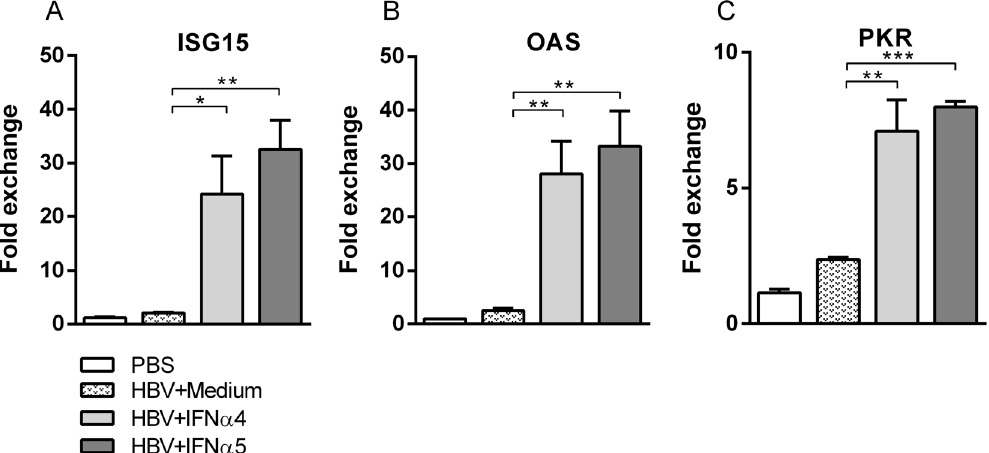
Figure 2. Induction of ISG15, OAS and PKR expression post treatment with recombinant IFN α 4 or IFN α 5. Mice received HI with 10 µ g of pAAV-HBV1.2 plasmids. Mice were treated i.p. with 8000 units of recombinant IFN α 4 or α 5 protein starting from days − 1 to 3 post HI. Control mice received either HI with PBS (PBS) or were treated i.p. with media (HBV + Medium). Total RNA was extracted from liver tissue at day 4 post HI and the mRNA expression levels of ( A ) ISG15, ( B ) OAS and ( C ) PKR were determined by qRT-PCR. The β -actin mRNA expression was quantified for normalization. Each sample was run in duplicate and at least four mice per group were analyzed. Differences between the groups were analyzed by using the One-way ANOVA. Statistically significant differences between the IFN-treated groups and the untreated control group are indicated by * for p < 0.05, ** for p < 0.01 and *** for p <